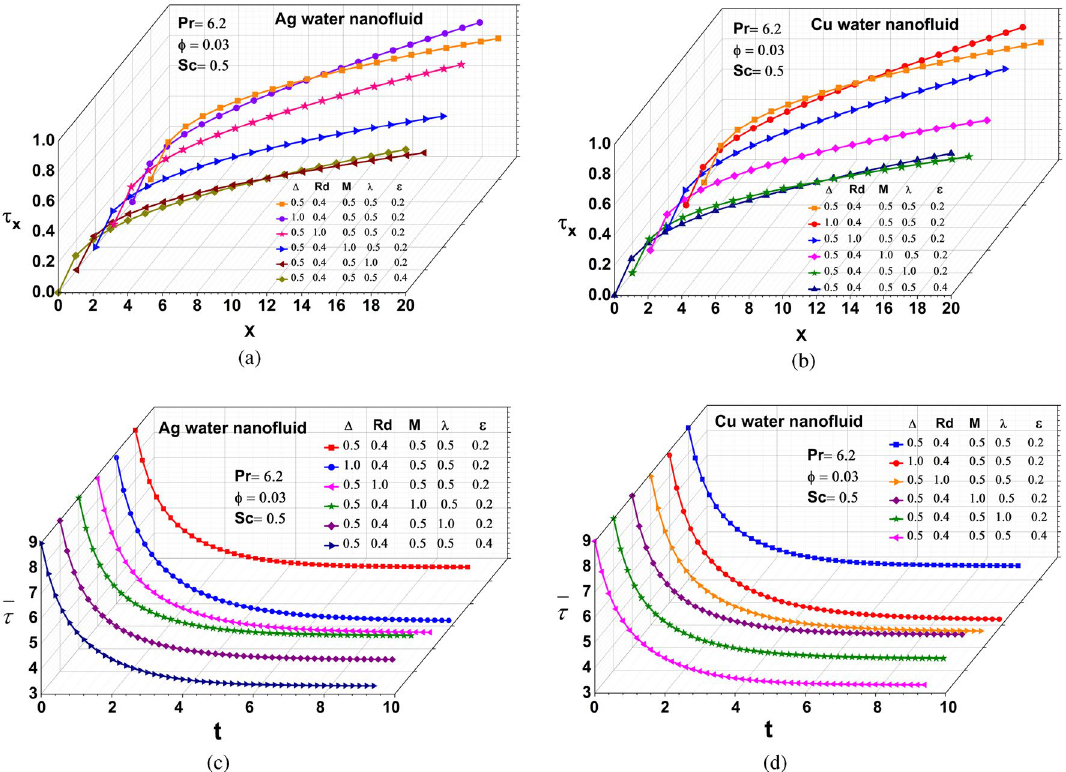
Figure 5. Local skin friction: ( a ) Silver ( b ) Copper, Average skin friction: ( c ) Silver ( d ) Copper.